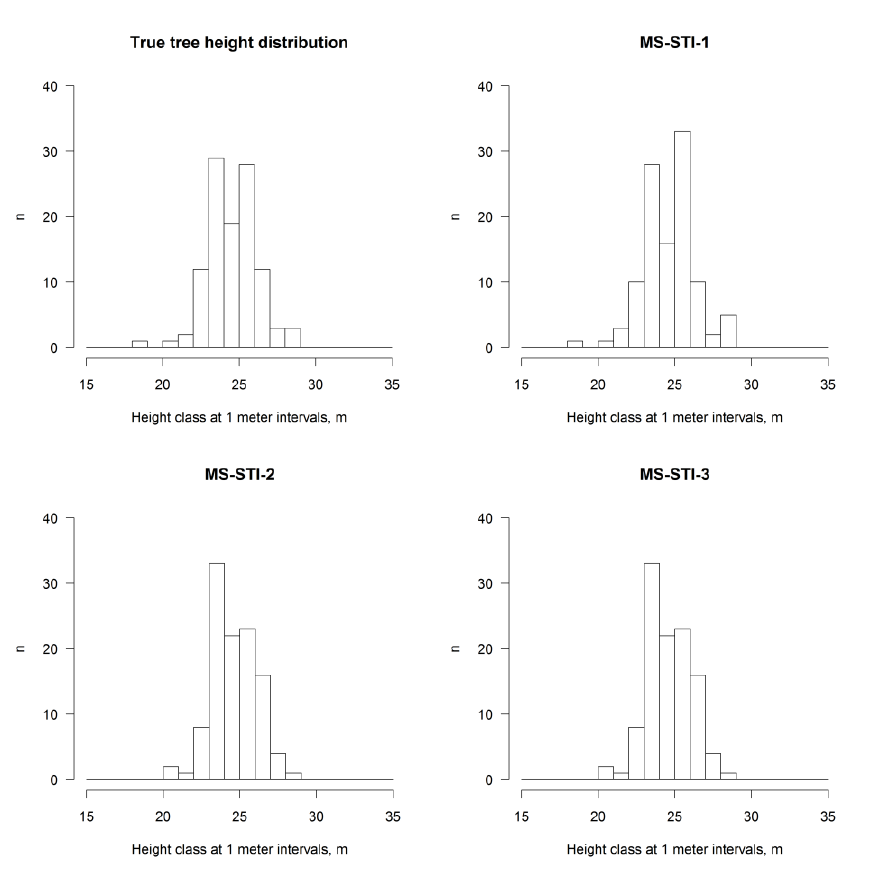
Figure 3. True and predicted tree-height